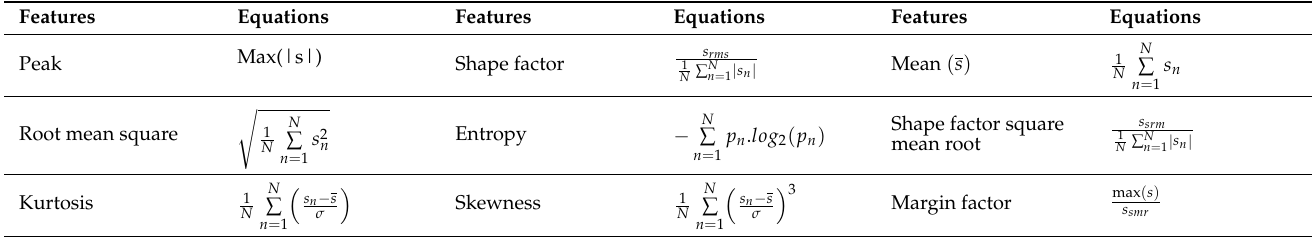
Table 3. The statistical features extracted in the time and frequency